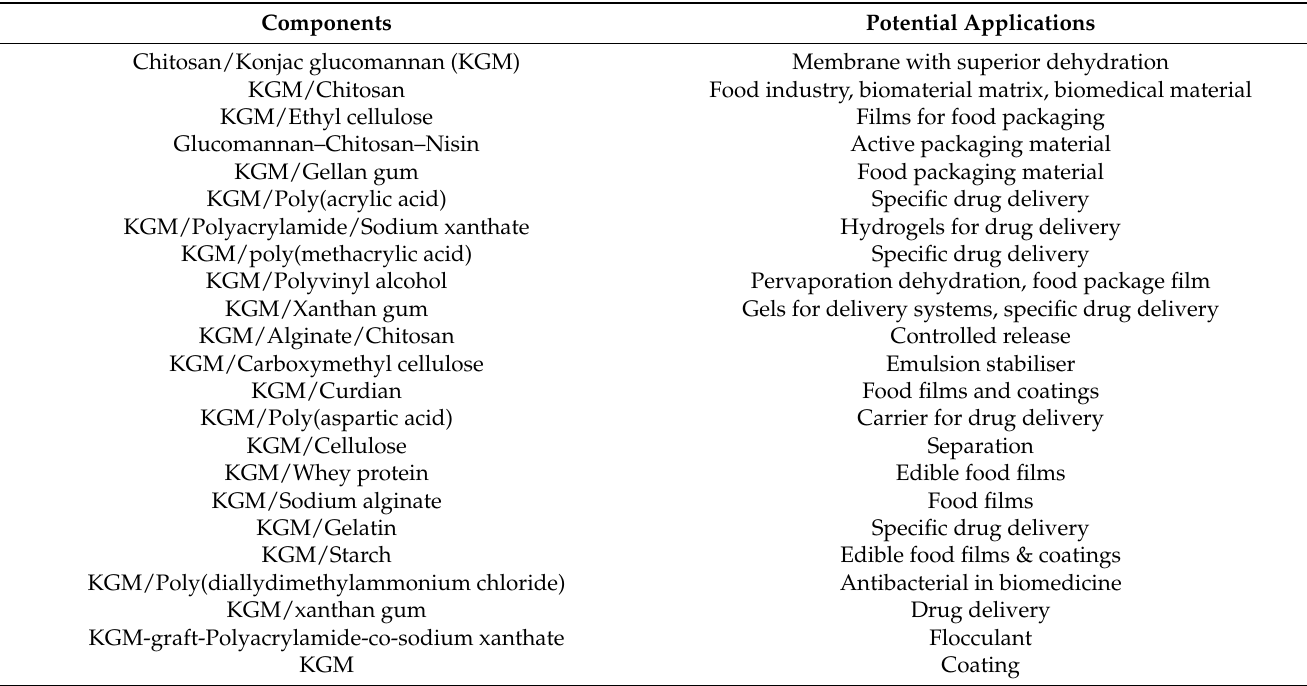
Table 9. Glucomannan-based materials, characterisation performed and future application prospects in various fields